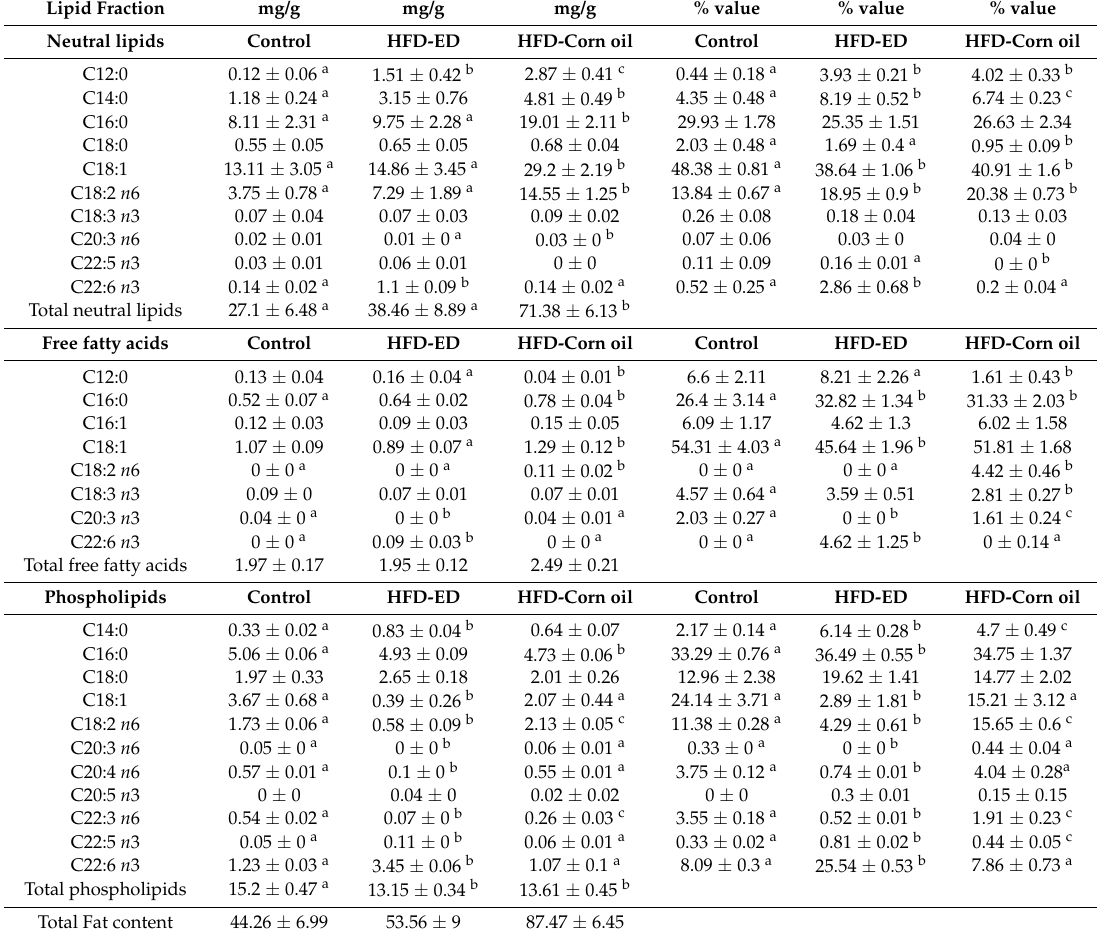
Table 3. The Fatty Acid Profiles of Different Lipid Fractions in Gastrocnemicus Skeletal Muscle. Lipid